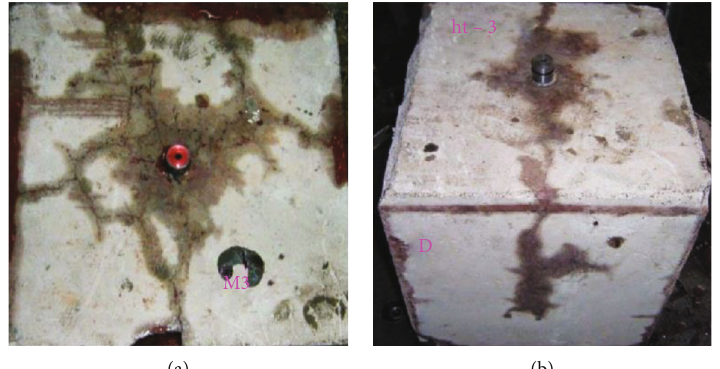
Figure 26: Experimental results of HF propagation pattern under di ff erent horizontal stress di ff erence: (a) 5MPa and (b) 10MPa [42]. 𝜎 1 Increase in the stress difference